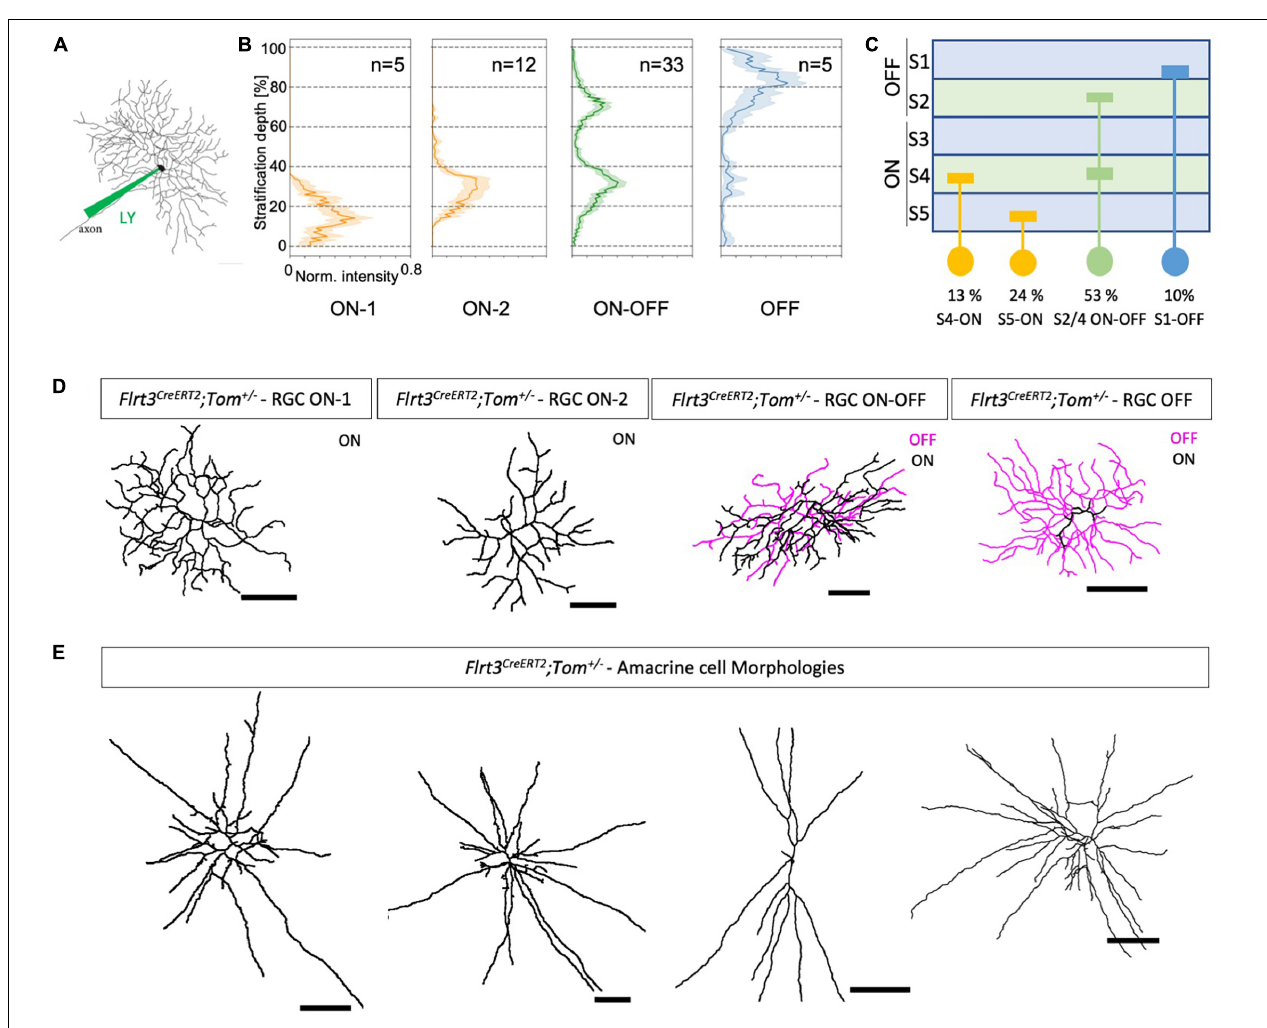
FIGURE 2 | Dye-filled RGCs revealing their morphology and stratification. (A) Injection of a fluorescent dye [Alexa 488 or Lucifer yellow (LY)] in Flrt3-RGCs with a borosilicate glass pipette using a patch-clamp setup and filling the whole neuron to assess the morphology of the cells. (B) Dendritic stratification pattern of Flrt3-RGCs in the IPL for ON, ON-OFF, and OFF cells. Stratification depth between the inner limiting borders of the GCL (=0%) and INL (=100%) defined by DAPI staining. N = 5 retinas from 4 mice. (C) Scheme summarizing the stratification pattern and their percentages. (D) Representative morphologies of Flrt3 RGCs stratifying in different IPL layers that were filled with Lucifer yellow and reconstructed using the Fiji Simple Neurite Tracer plugin. (E) Different morphologies of Flrt3 amacrine cells of the INL. Scale bars = 50 µ